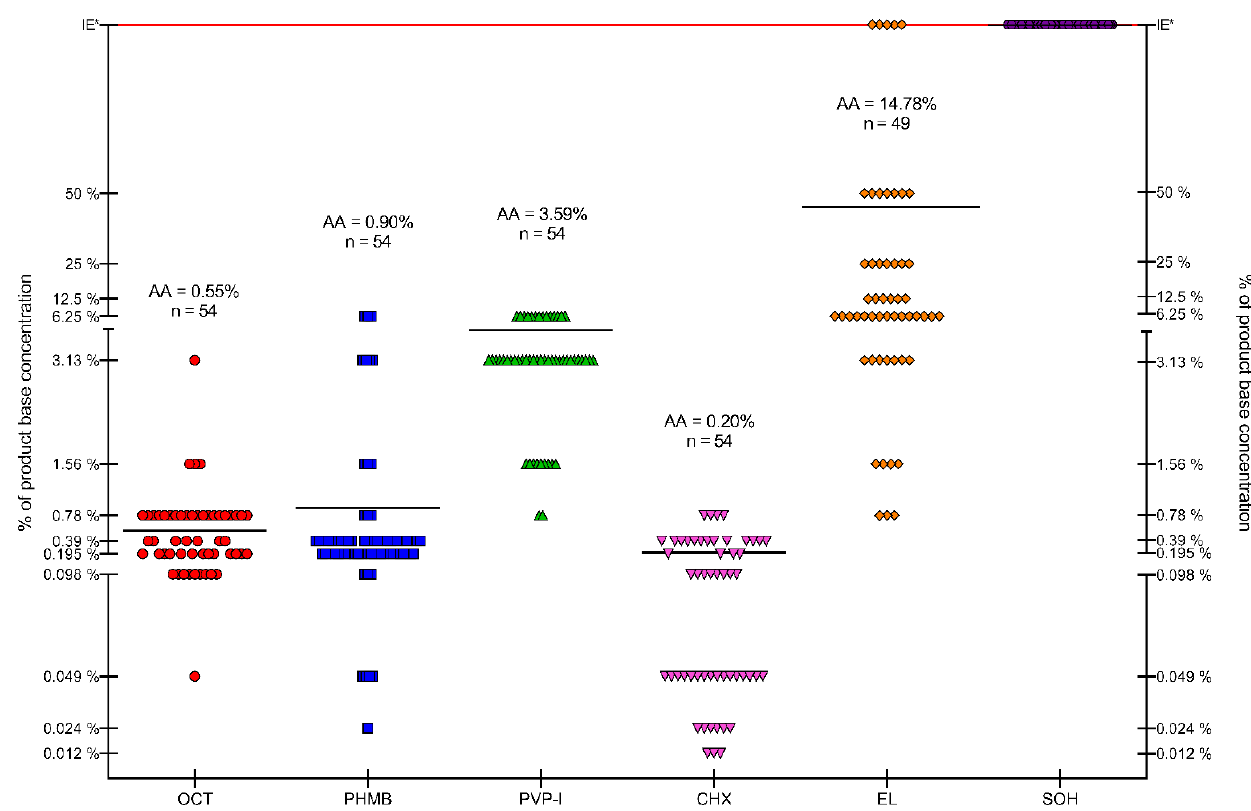
Figure 7. Distribution of MIC values of the tested substances in the pool of strains. OCT — octenidine dihydrochloride, PHMB — polyhexanide, PVP-I — povidone-iodine, CHX — chlorhexidine, EL — ethacridine lactate, SOH — super-oxidized hypochlorites solution. AA — arithmetic average of MIC values for all strains, n — number of strains included in AA, IE * — compound ineffective in tested concentration range.